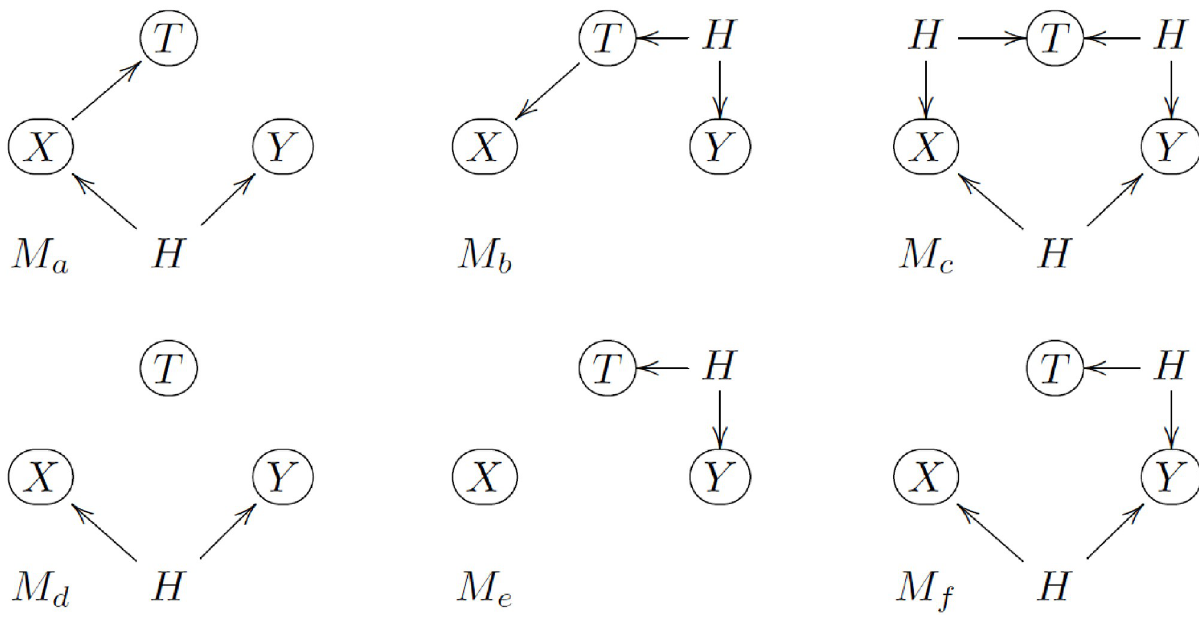
Fig 3. Alternative models involving unmeasured confounders, H